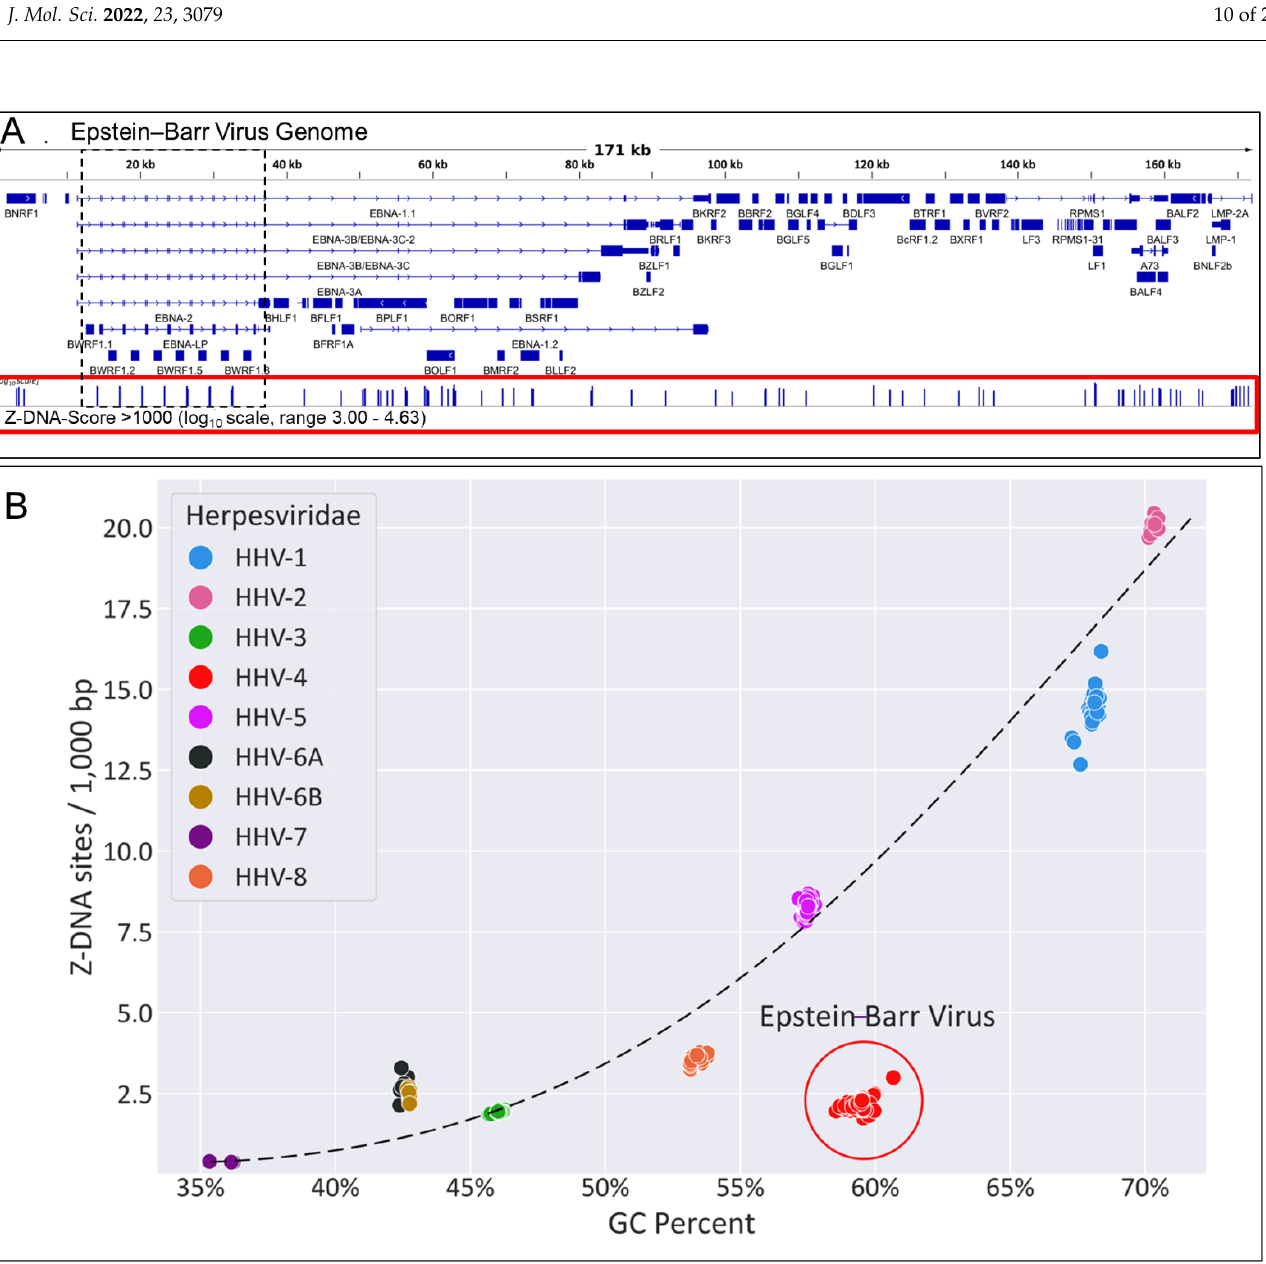
Figure 5. ZBP1, flipons and disease with evidence of the evolutionary selection against Z-DNA forming regions in the EBV genome. ( A ). The EBV genome is characterized by strong Z-DNA forming segments in gene promoters. Vertical lines in the red box show the position of sequences with a Z-Score greater than 1000, as determined using the Z-HUNT3 algorithm [2]. Sequences such as these that change their DNA conformation under physiological conditions are called flipons. They can act as switches to turn gene expression “on” or “off” [71]. The region in the dotted box is expanded on panel D of Figure 6 ( B ). A plot of GC content of different herpes virus (HHV) genome sequences against the number of sequences per 100,000 base pairs with a high propensity to form Z-DNA under physiological conditions (with ZHUNT3 scores >1000). Independent isolates from the various labeled strains are shown. The dashed line represents the expectation that the number of Z-forming sequences increases with GC content. The Epstein virus group of sequences is shifted to the right of this line, consistent with selection against Z-DNA forming sequences in plasma cells.